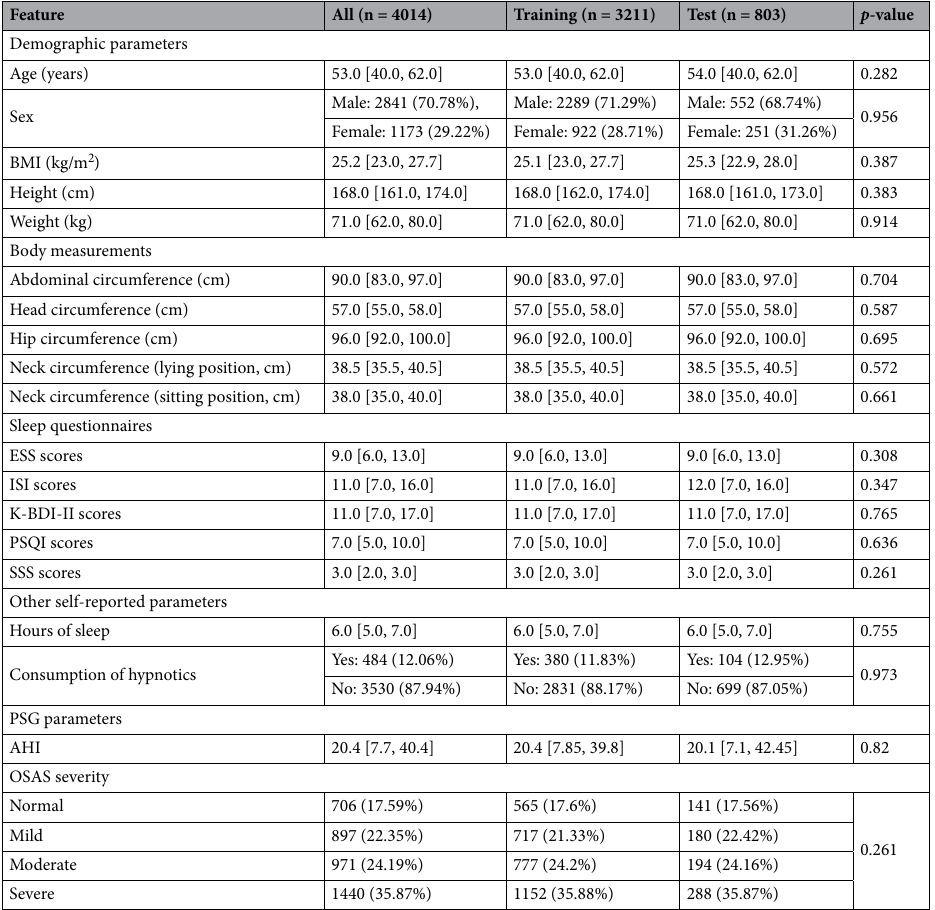
Table 1. The report of statistical analysis. Data are resported as median [interquartile range] or number (percentage). BMI: Body Mass Index, ESS: Epworth Sleepiness Scale, ISI: Insomnia Severity Index,